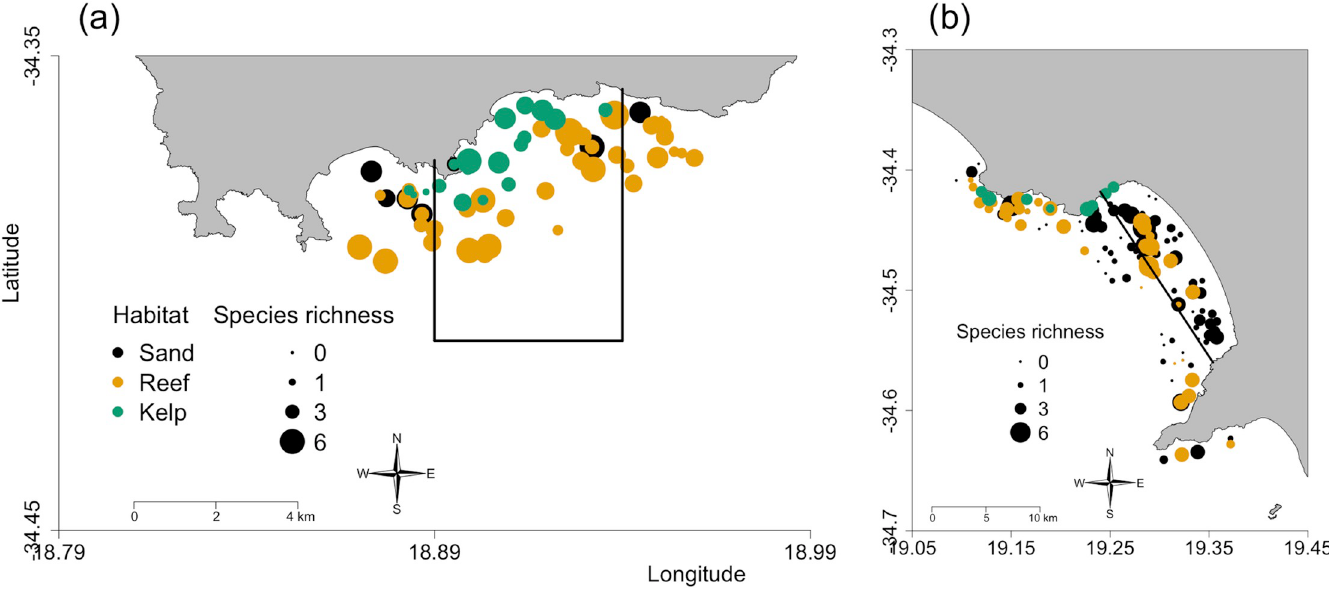
Fig 4. Maps of the study area showing BRUV sites categorized by habitat and species richness in (a) Betty’s Bay and (b) Walker Bay.